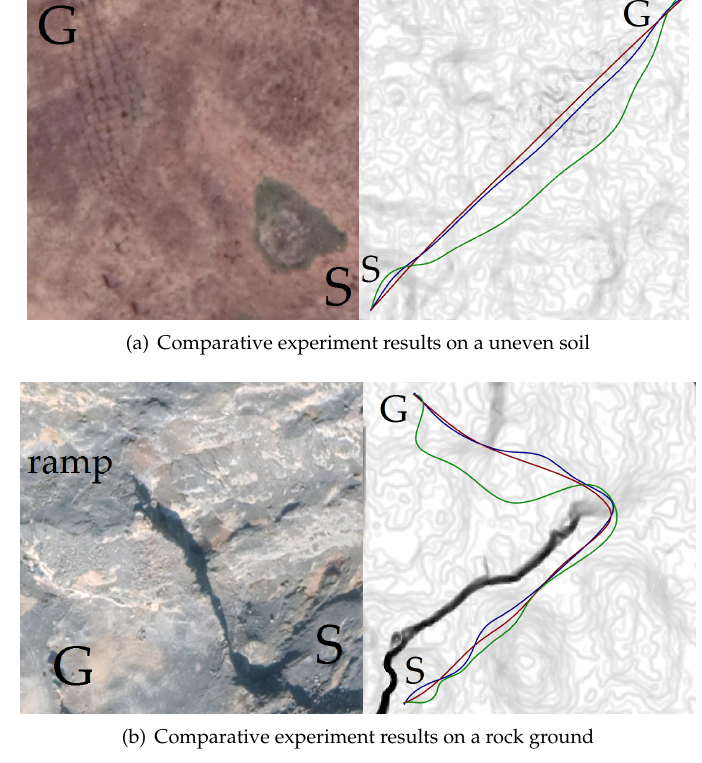
Figure 21. The trajectories generated by NoTS (red), TS-NoSus (green), and TS-Sus